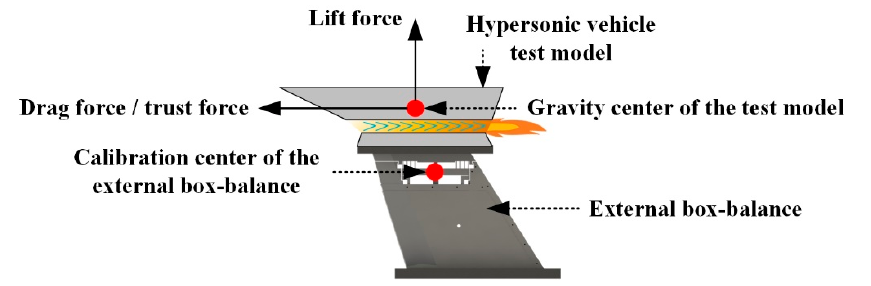
Figure 3. Three-dimensional model diagram of external box-balance.